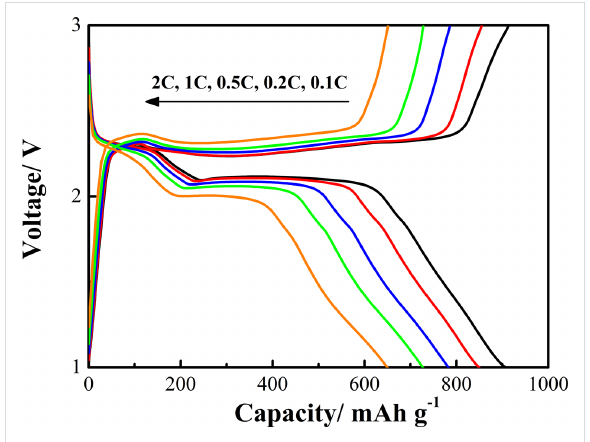
Figure 11: Discharge/charge voltage profiles of S/ZnO@NCNT com- posite cathode at various